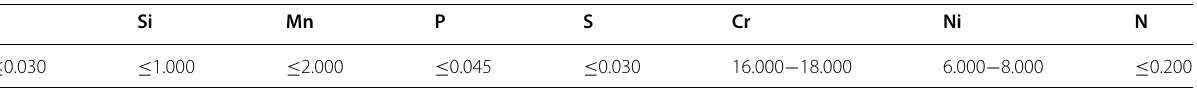
Table 1 Composition of SUS301L-MT stainless steel (mass fraction, %)